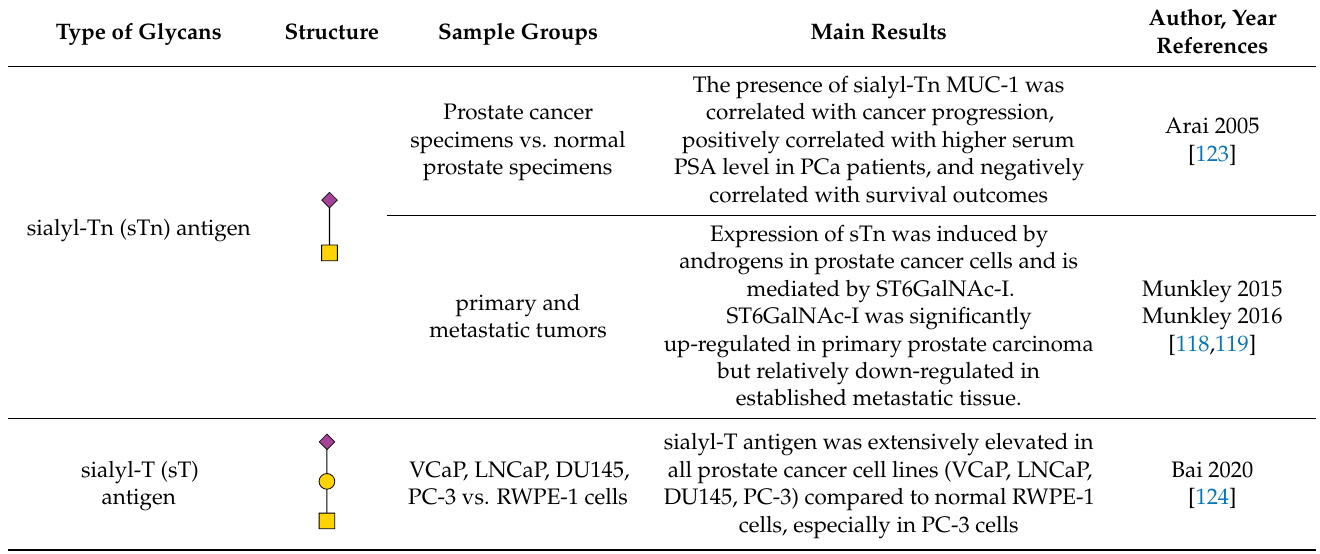
Table 3. Summary of truncated O-glycan alternations in prostate cancer.